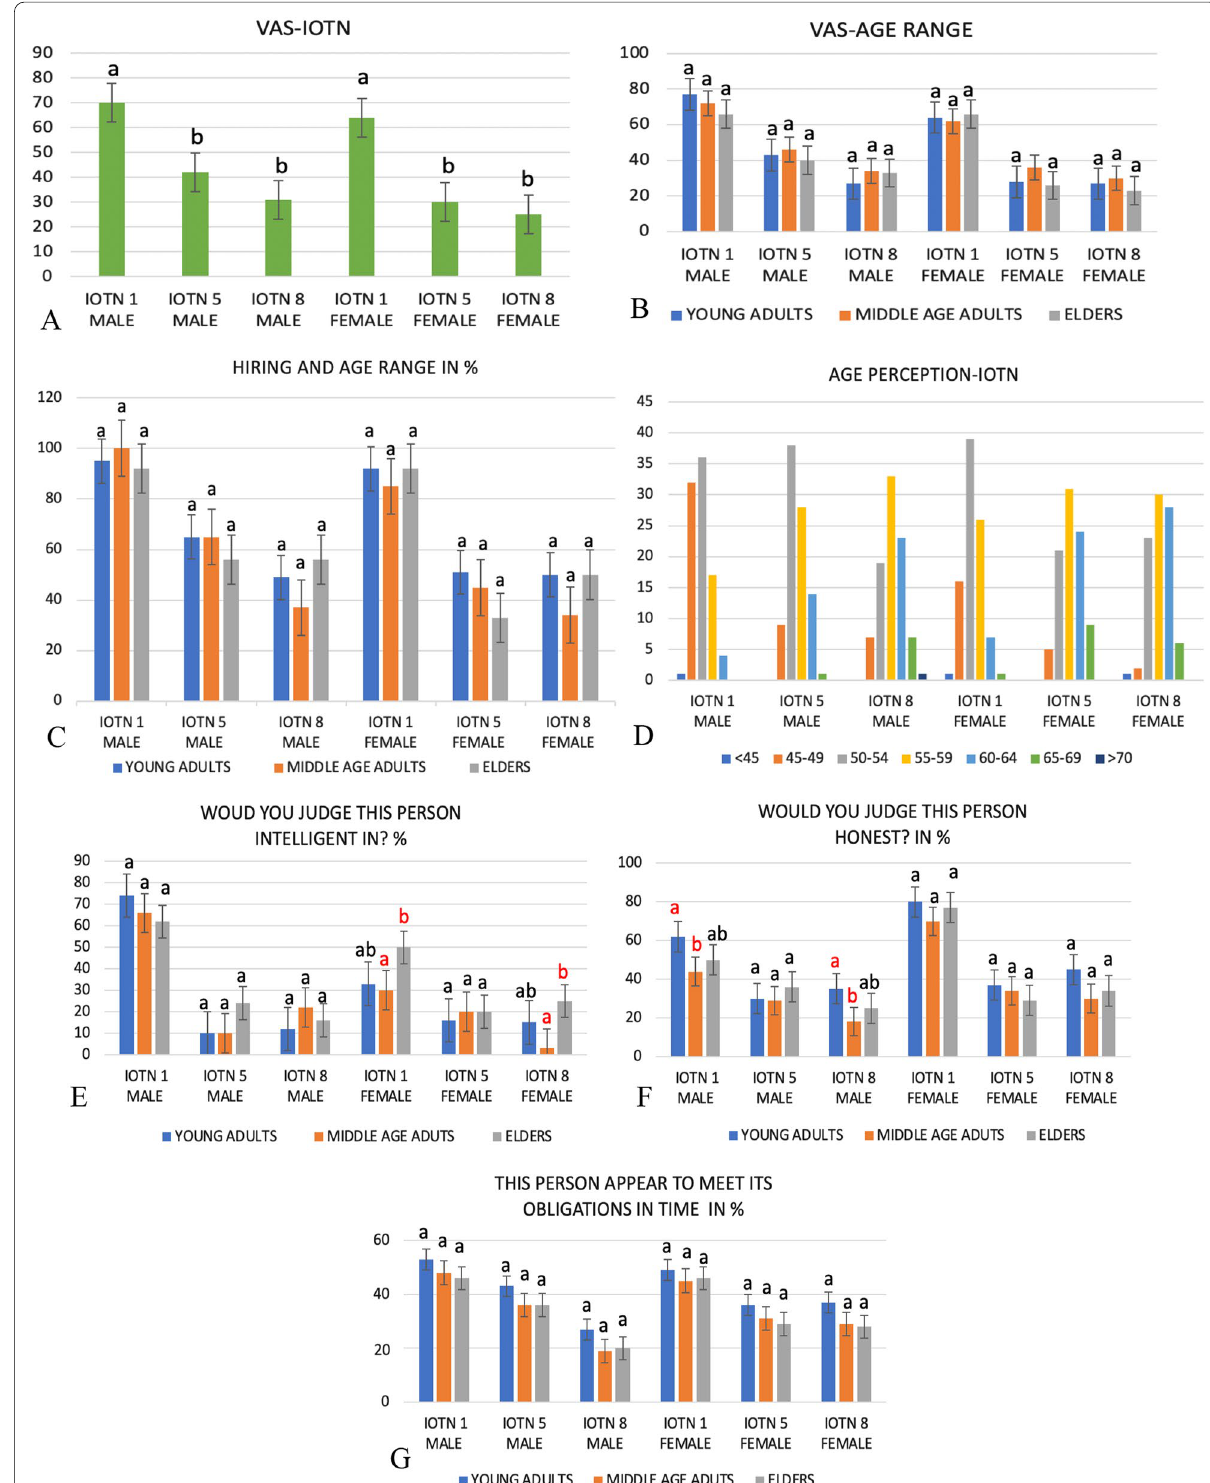
Fig. 2 Cross-tabulation comparing A mean VAS and IOTN; B mean VAS and age range; C Hiring and age range; D Age perception and IOTN; E Intelligence and age range; F Honesty and age range; G Obligations in time and age range. Statistical difference p < 0.005. Different letters Statistical